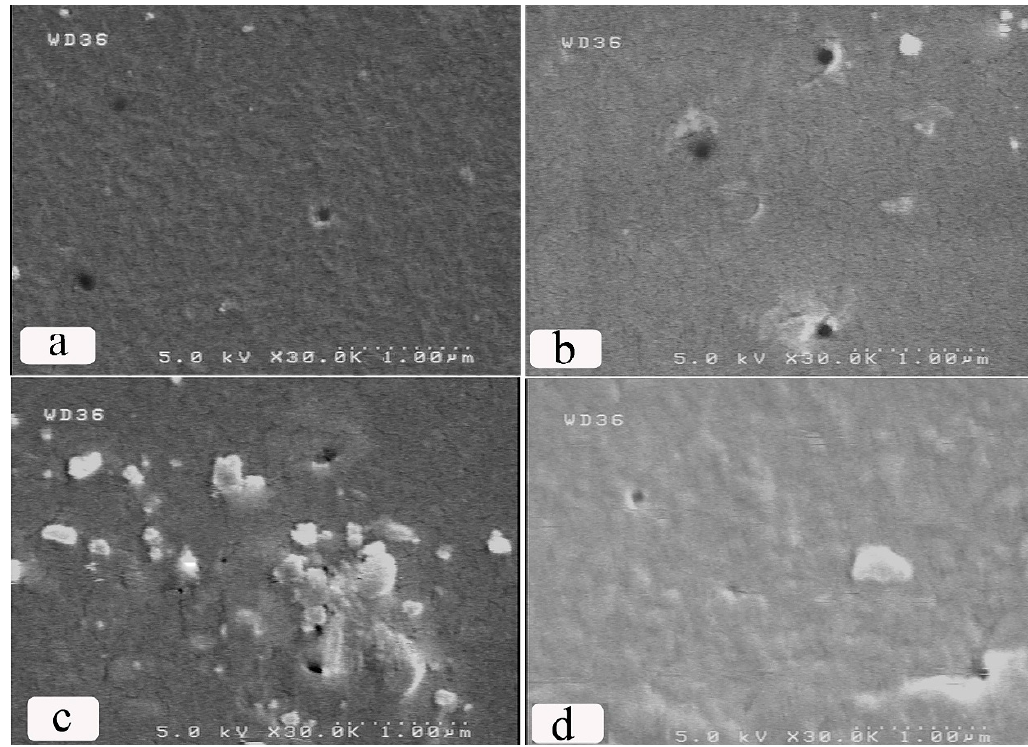
Figure 5. The field emission scanning electron microscopy (FESEM) micrographs of the reference sample ( a ), S1 ( b ), S2 ( c ), and S3 ( d ).